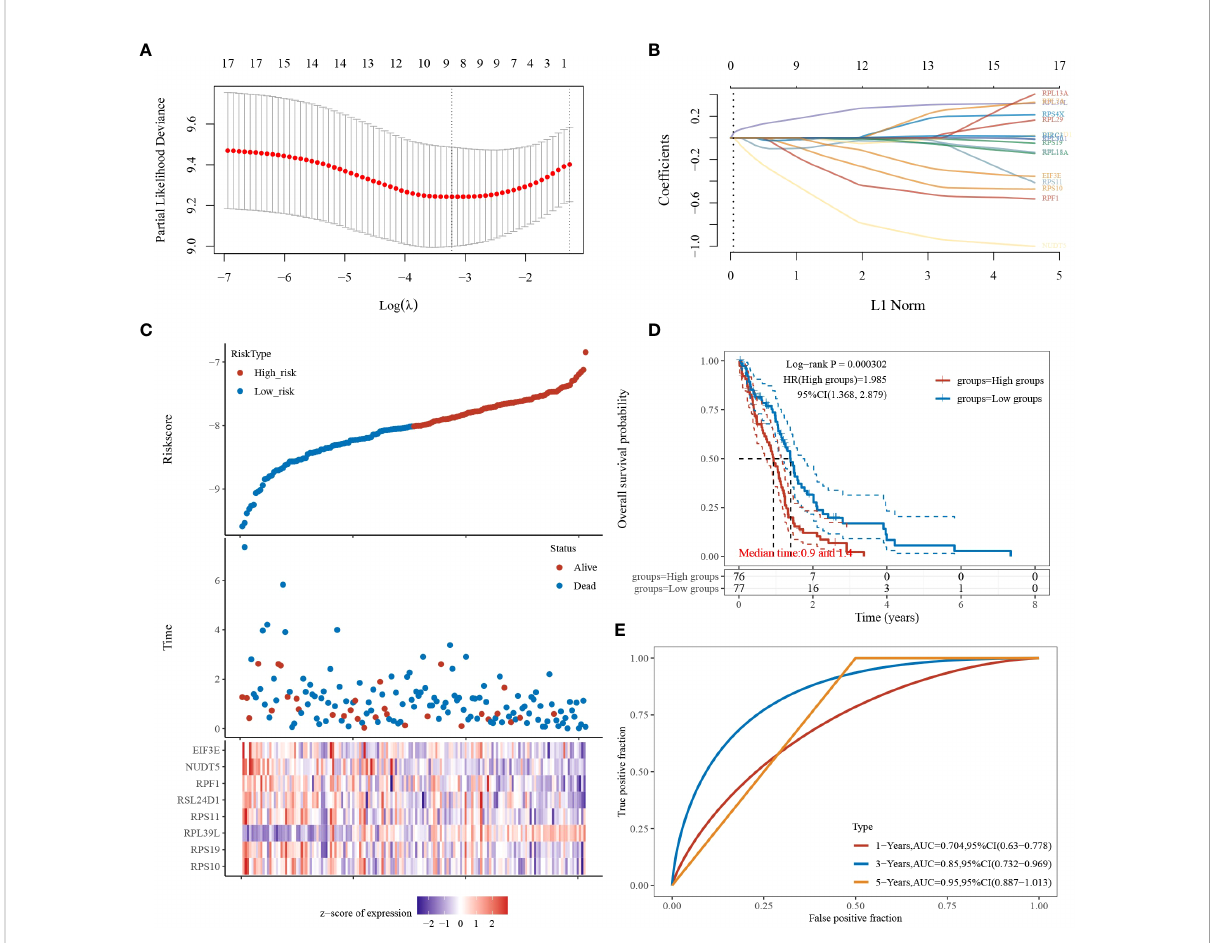
FIGURE 3 LASSO analysis of the 17 genes derived from PPI analysis. (A) The coef fi cients of selected features are shown by the lambda parameter, the horizontal coordinate represents the value of the independent variable lambda, and the vertical coordinate represents the coef fi cient of the independent variable. (B) The partial likelihood deviation was plotted against log( l ) using the LASSO Cox regression model. (C) Risk score, survival time, and survival status in the selected dataset, presented using scatter plots and heat maps. (D) KM survival curves with median risk values as groupings. (E) ROC curves for the risk